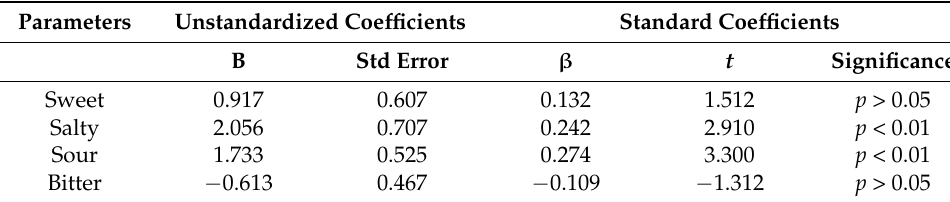
Table 4. Multivariate linear regression analyses in all subjects. TDI score as dependent variable.